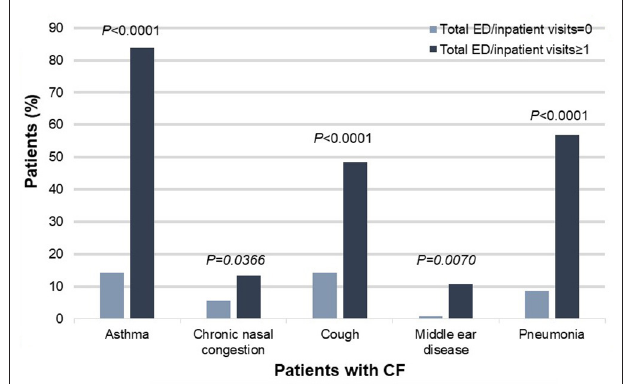
FIGURE 2 | Co-diagnoses that significantly differed between patients with CF and poor health outcomes (defined as one or more ED or inpatient visits for respiratory issues) vs. patients with CF and better health outcomes (defined as zero ED or inpatient visits for respiratory issues), N = 163, P < 0.05. CF, cystic fibrosis; ED, emergency